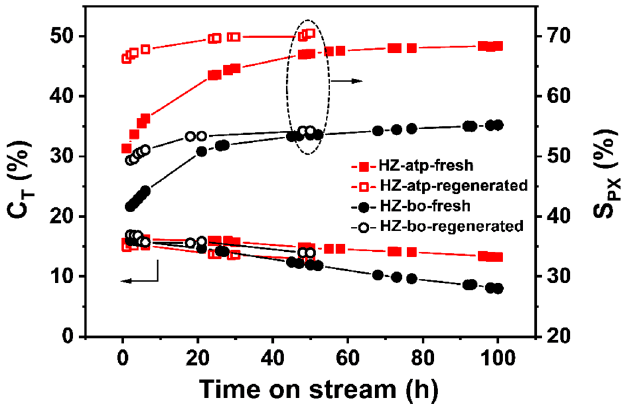
Figure 7. Toluene conversion and para-selectivity as a function of time on stream over HZ-atp (square) and HZ-bo (circle). Solid for fresh catalysts and open for regenerated catalysts.